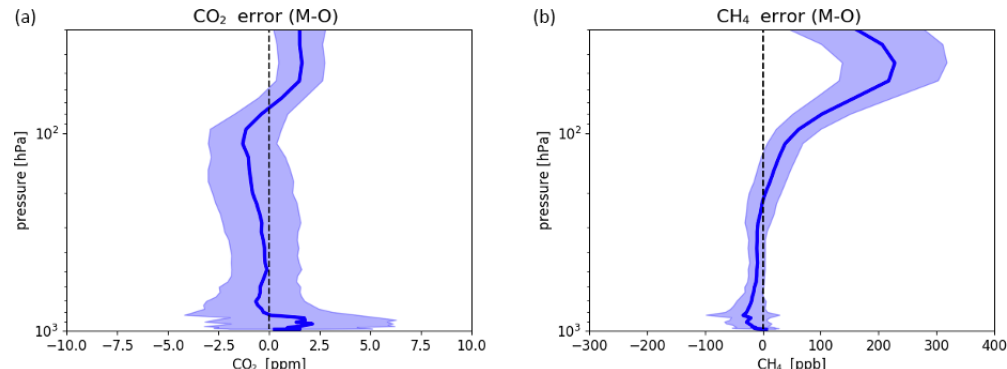
Figure 13. Vertical profiles of mean error (model minus observation, M–O) of CAMS CO 2 (a) and CH 4 (b) reanalysis with respect to AirCore observations comprising 133 profiles at seven sites (listed in Table A3) over the period from 2012 and 2020. The blue shading shows the ± standard deviation of M–O with respect to the mean error. The vertical dashed black line depicts the zero mean error.